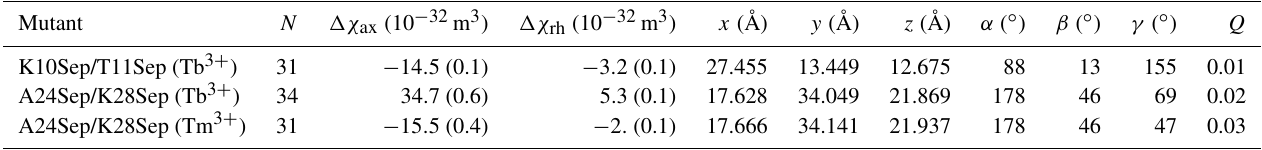
Table 2. (cid:49)χ -tensor parameters of the GB1 mutants K10Sep/T11Sep and A24Sep/K28Sep a . Mutant N (cid:49)χ ax (10 − 32 m 3 ) K10Sep/T11Sep (Tb 3 +